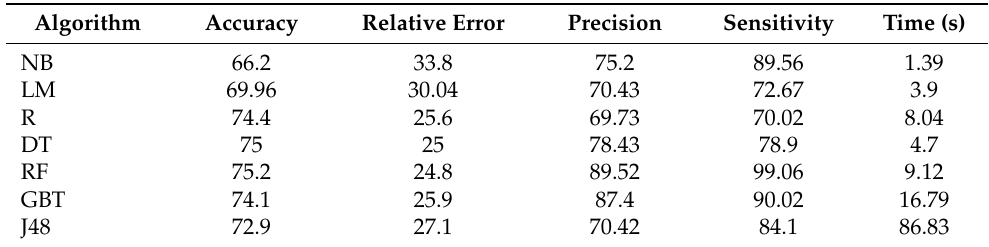
Table 4. Comparison between different algorithms applied on heart disease data without preprocess- ing.